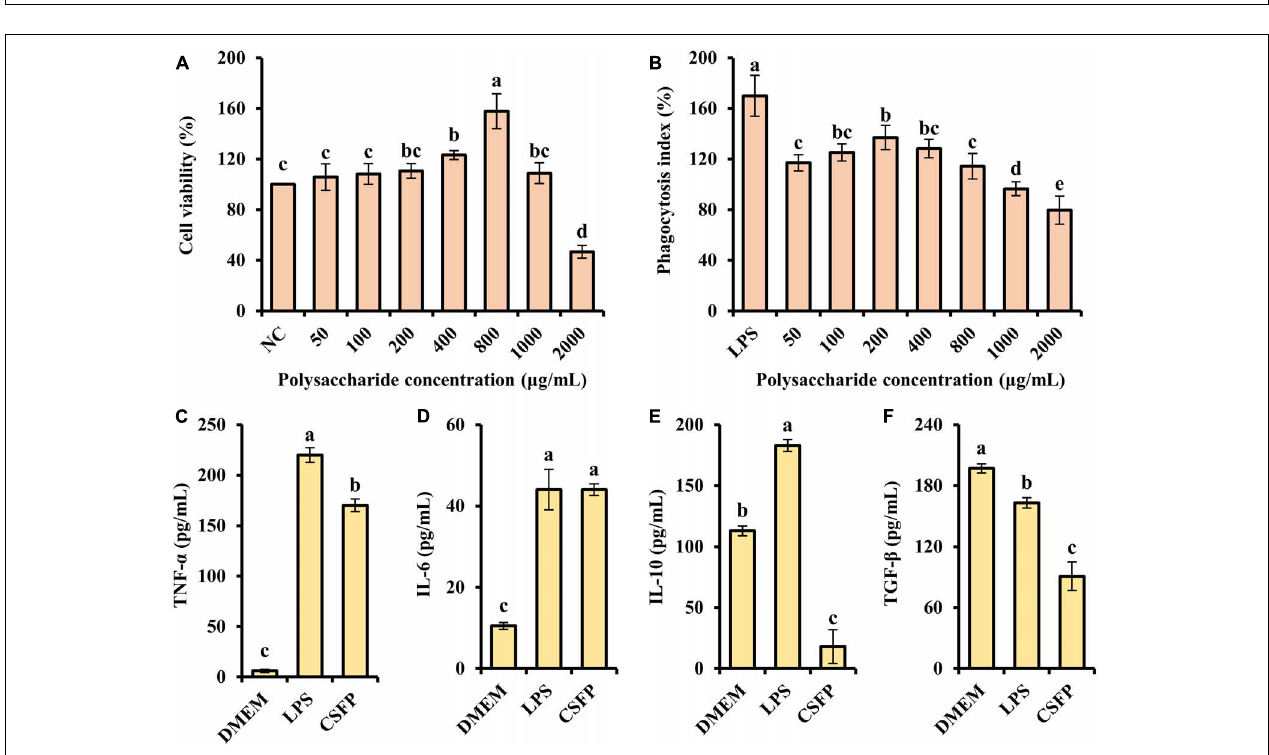
FIGURE 9 | Effect of CSFP on the growth of RAW264.7 cell in vitro . (A) Cell viability, (B) Phagocytosis index, (C–F) Secretion of cytokines TNF- α , IL-6, IL-10, and TGF- β . Data are expressed as the mean ± standard deviation values ( n = 3), and different lowercase letters denote statistical significance ( p <